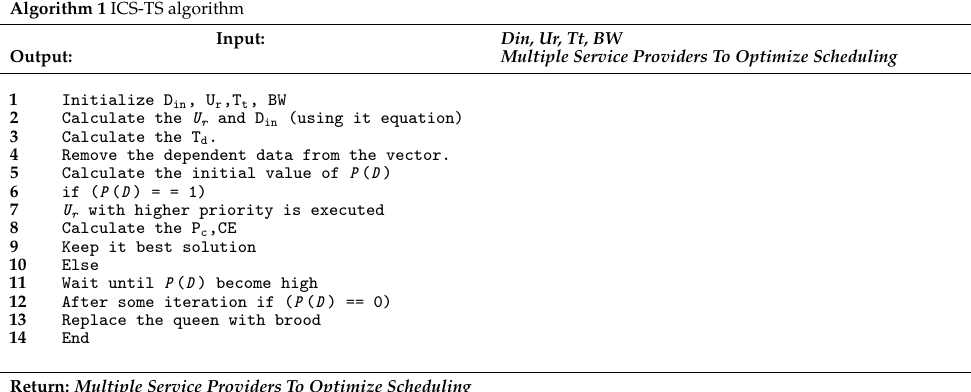
Algorithm 1 ICS-TS